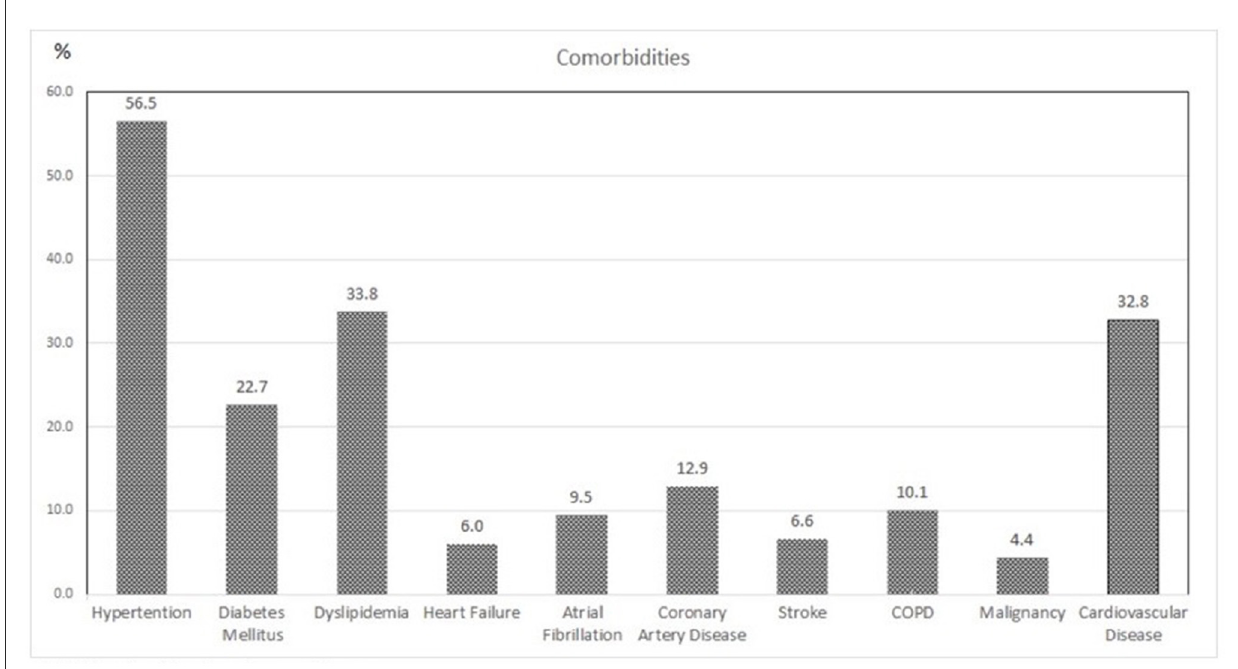
FIGURE1 Associated comorbidities of the study population. COPD, chronic obstructive pulmonary disease.